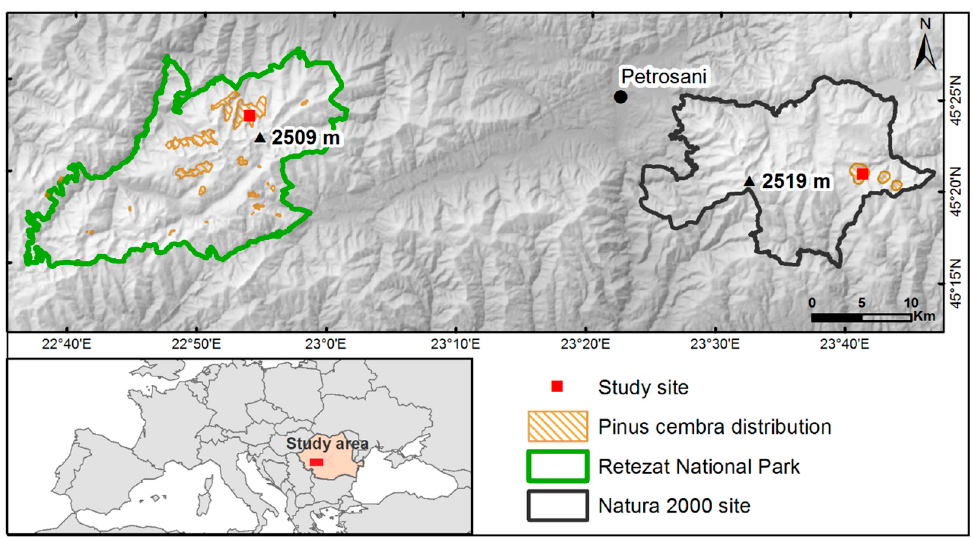
Figure 1. Study sites in the Southern Carpathians, Romania.